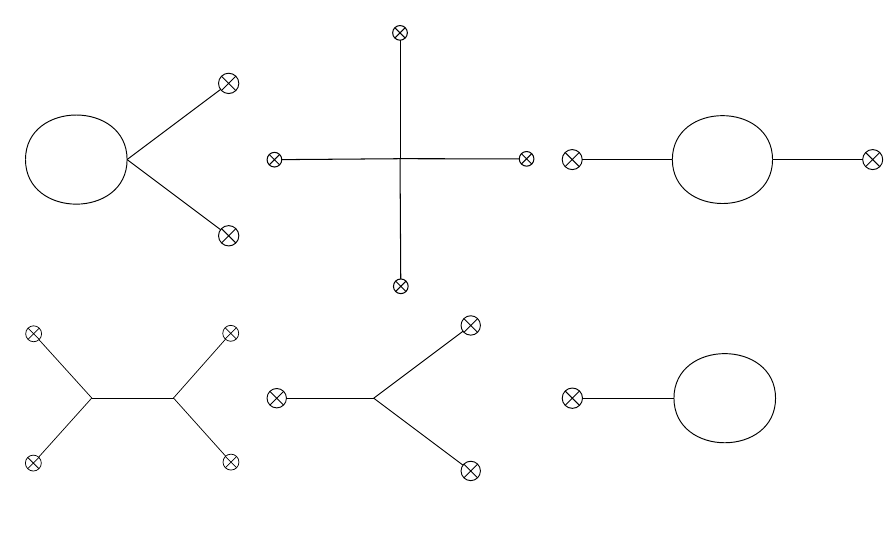
Figure 12 . NLO diagrams contributing to the statistical